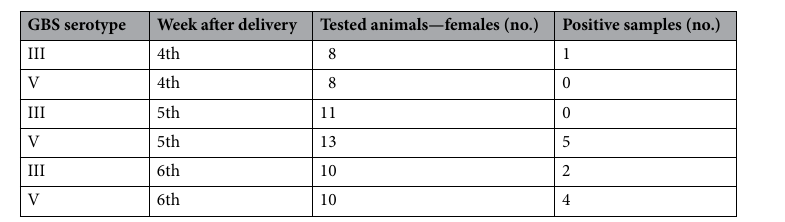
Table 1. GBS vaginal colonization of intranasal infected animals occurred during the first weeks of life.